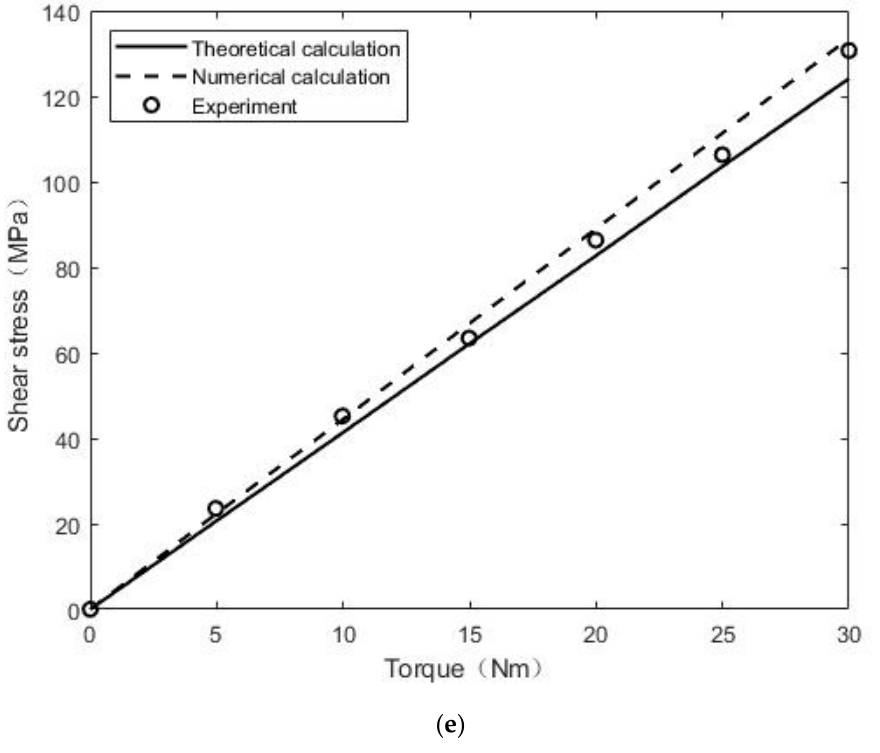
Figure 10. Torsional mechanical characteristics of thin-walled bar with an open cross-section. ( a ) Torsional angle. ( b ) Shear stress at point A. ( c ) Shear stress at point B. ( d ) Shear stress at point C. ( e ) Shear stress at point D.